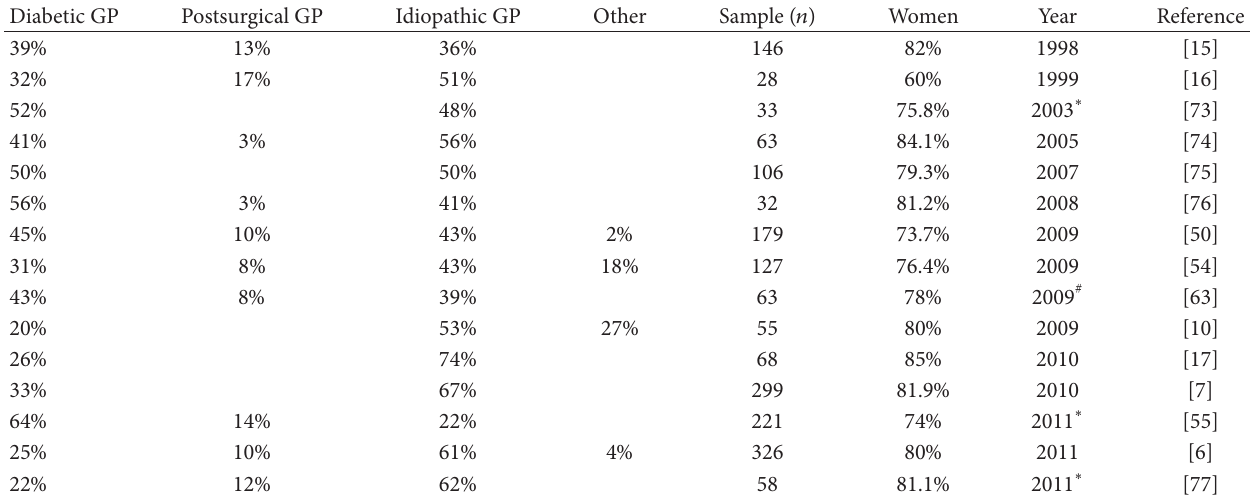
T 2: Distribution of different etiologies for gastroparesis in published case